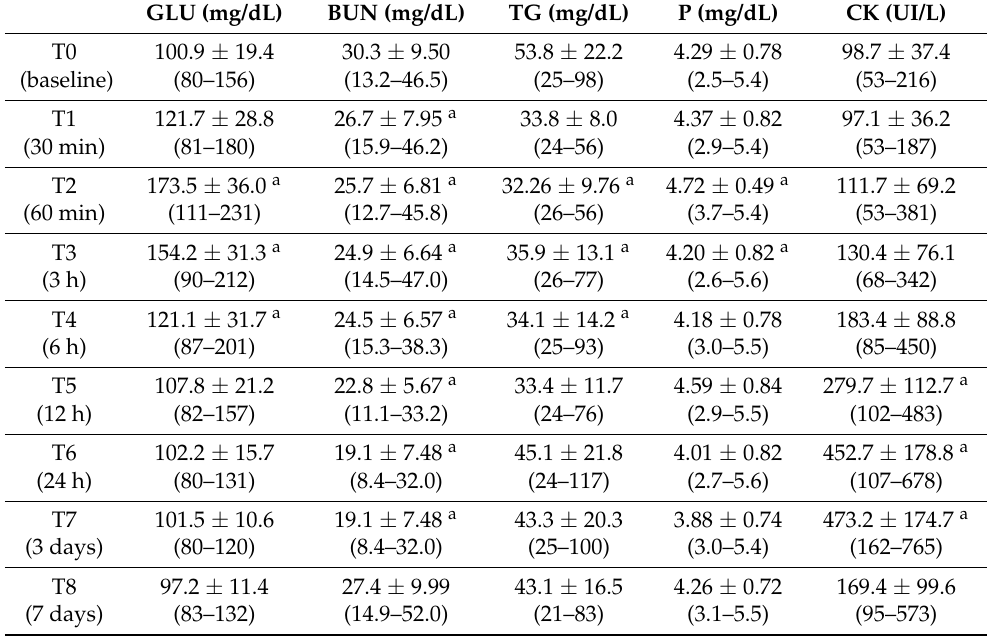
Table 2. Pre-, intra- and post- mean ± SD of plasma glucose, BUN, triglycerides and phosphorus concentrations, and plasma CK activity in healthy bitches. Letter indicates significant differences vs. baseline values: a p <